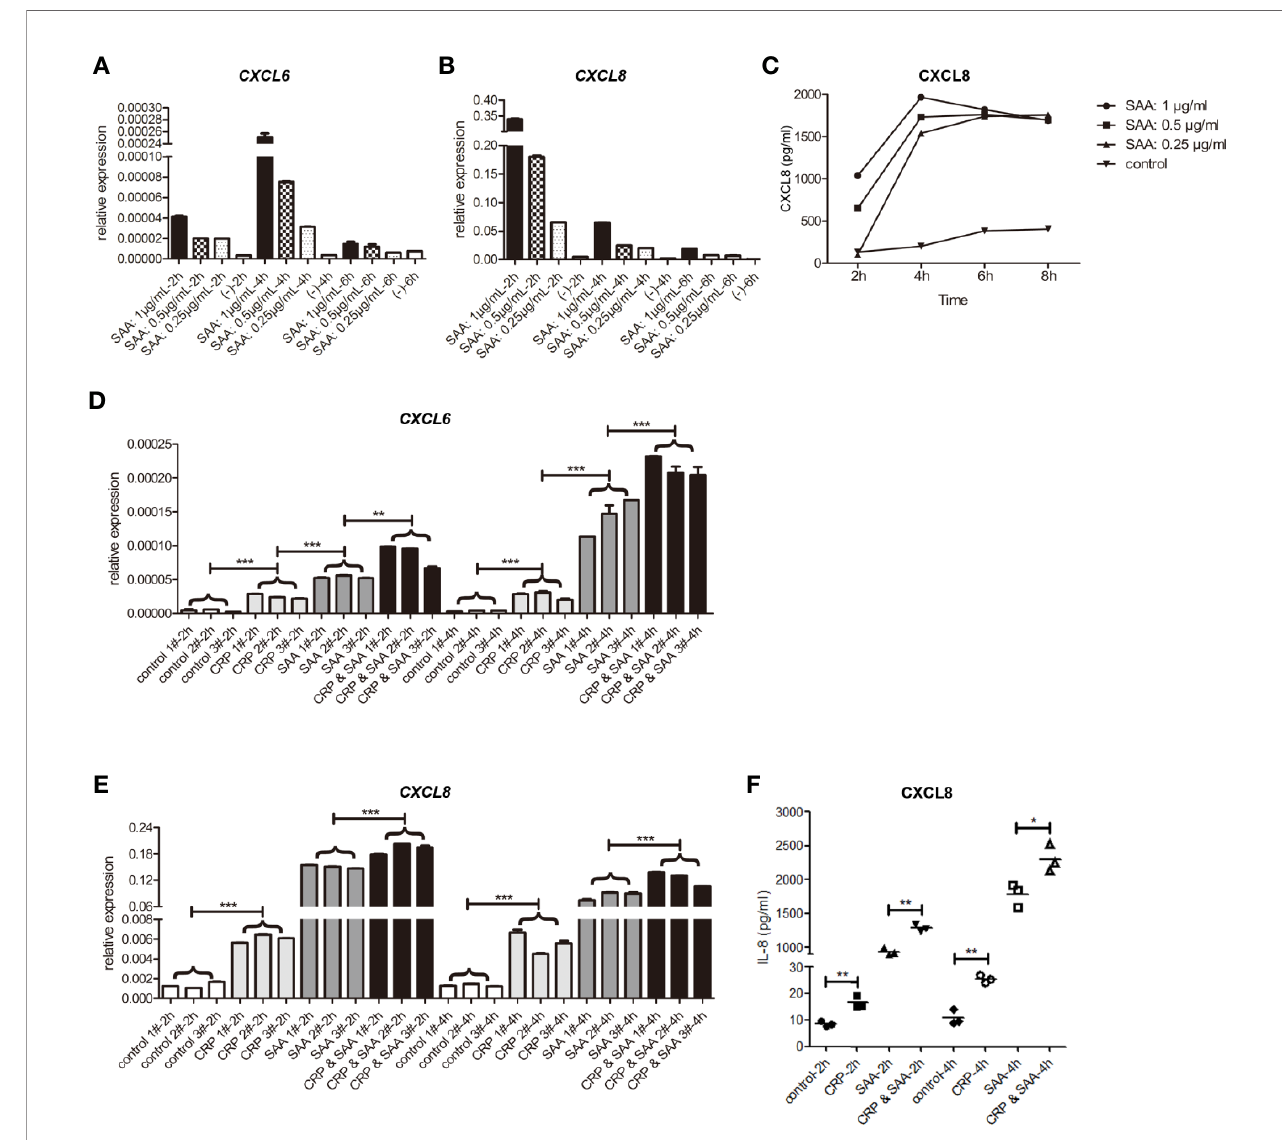
FIGURE 2 | The relative expression of mRNA of CXCL6 (A) and CXCL8 (B) stimulated by SAA of different concentrations (0, 0.25, 0.5, 1 m g/mL) and durations (2 h, 4 h, 6 h) in THP1. (C) The levels of CXCL8 in the supernatant were detected by ELISA. The relative expression of mRNA of CXCL6 (D) and CXCL8 (E) in THP1 stimulated by the control, CRP (1 m g/mL), SAA (1 m g/mL), or CRP (1 m g/mL) and SAA (1 m g/mL) for different duration (2 h, 4 h) from three independent replicates of each experiment. (F) The levels of CXCL8 in the supernatant were detected by ELISA. The asterisk indicates signi fi cant difference in cell surface area compared to the control, using the Student t-test (* P < 0.05, ** P < 0.01, *** P <